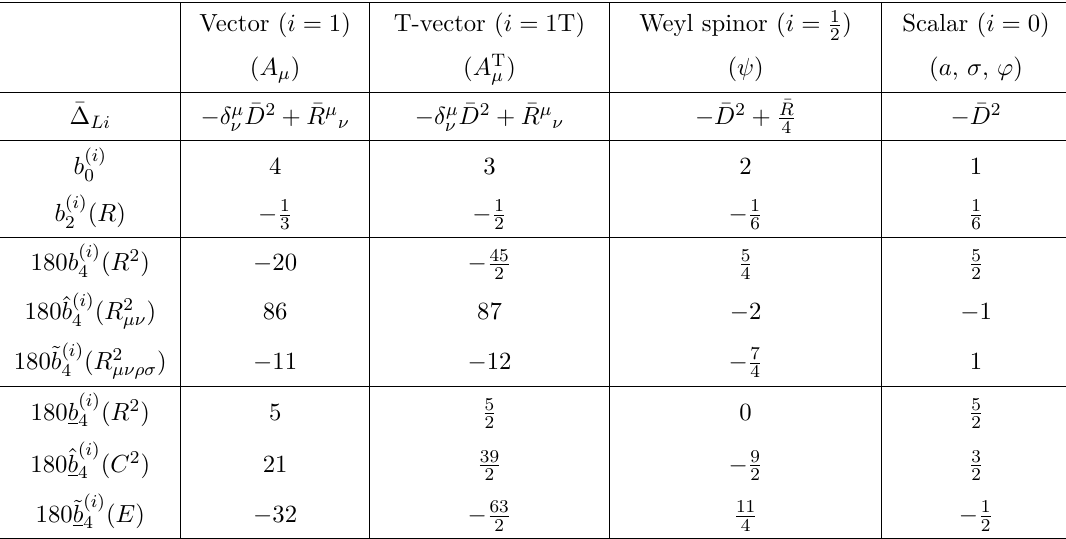
Table 1 . Heat kernel coefficients for the Lichnerowicz Laplacians ¯∆ Li acting on individual matter fields in a general four dimensional constant background. The abbreviation “T” denotes